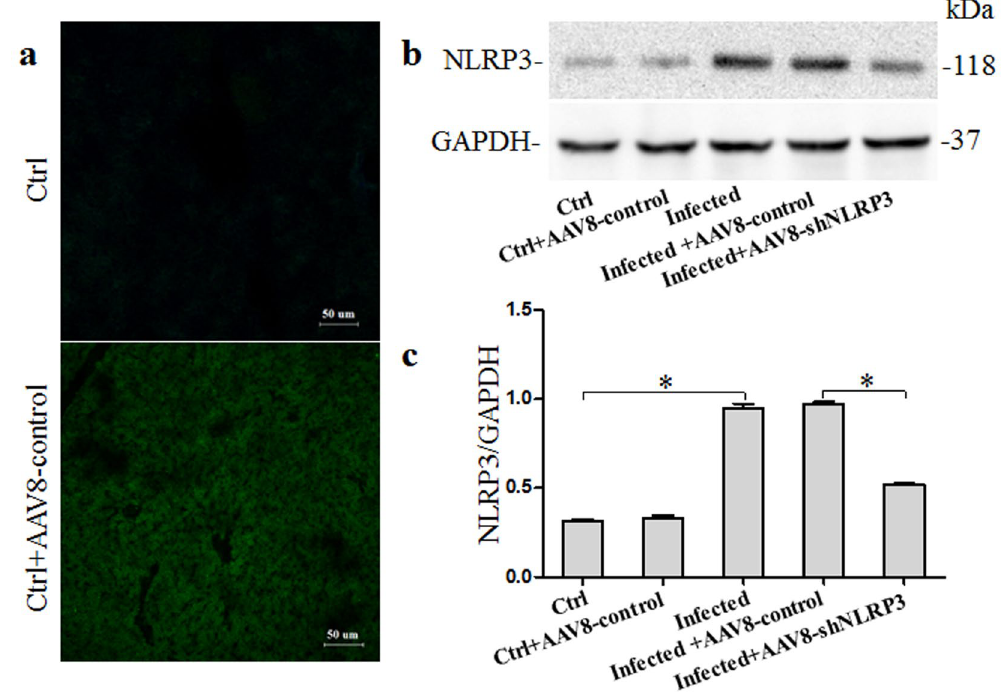
Figure 1. Verification of AAV8 insertion and inhibition of NLRP3 in the liver tissues of mice infected wth S. Japonicum : ( a ) representative confocal fluorescence image showing GFP expression in the liver; ( b ) western blot gels and ( c ) summarized data showing the expression of NLRP3, full-length blots are included in the Supplementary Fig. S1. Ctrl: control (n = 4); Ctrl + AAV8-control: control mice injected with AAV8-control which express GFP (n = 4); Infected: mice infected with S. Japonicum (n = 6); Infected + AAV8-control: Infected mice injected with AAV8-control (5 × 10 9 vg per animal) (n = 6); Infected + AAV8-shNLRP3: Infected mice injected with AAV8-shNLRP3 (5 × 10 9 vg per animal) (n = 6). Results are a representative of at least three independent experiments. * p <